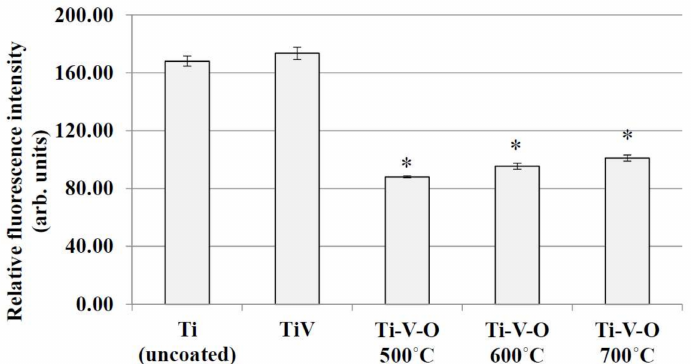
Figure 10. Antibacterial effects of the Ti (uncoated) sample, TiV coating, and HTA Ti-V-O coating. * Significantly different from the control group—uncoated Ti plate ( p < 0.01).